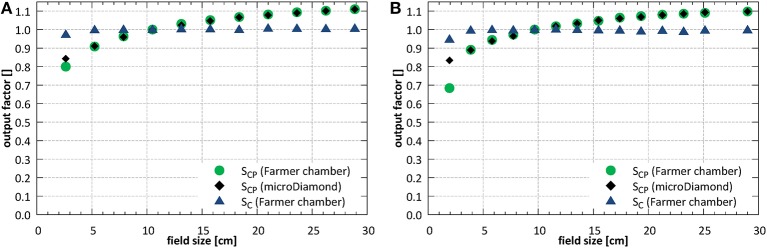
Total (SCP) and collimator (SC) scatter factors (A) at SID of 2.4 m and (B) at SID of 1.8 m.